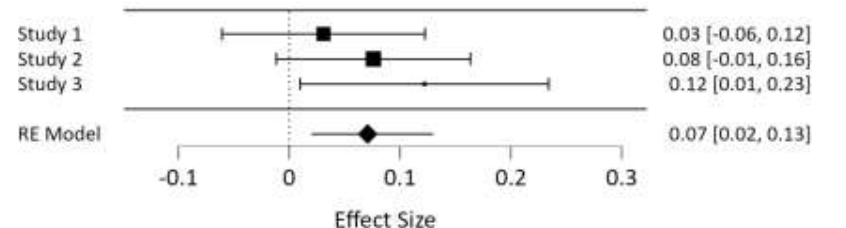
Figure 5. Forest plot of meta-analysis of External regulation and